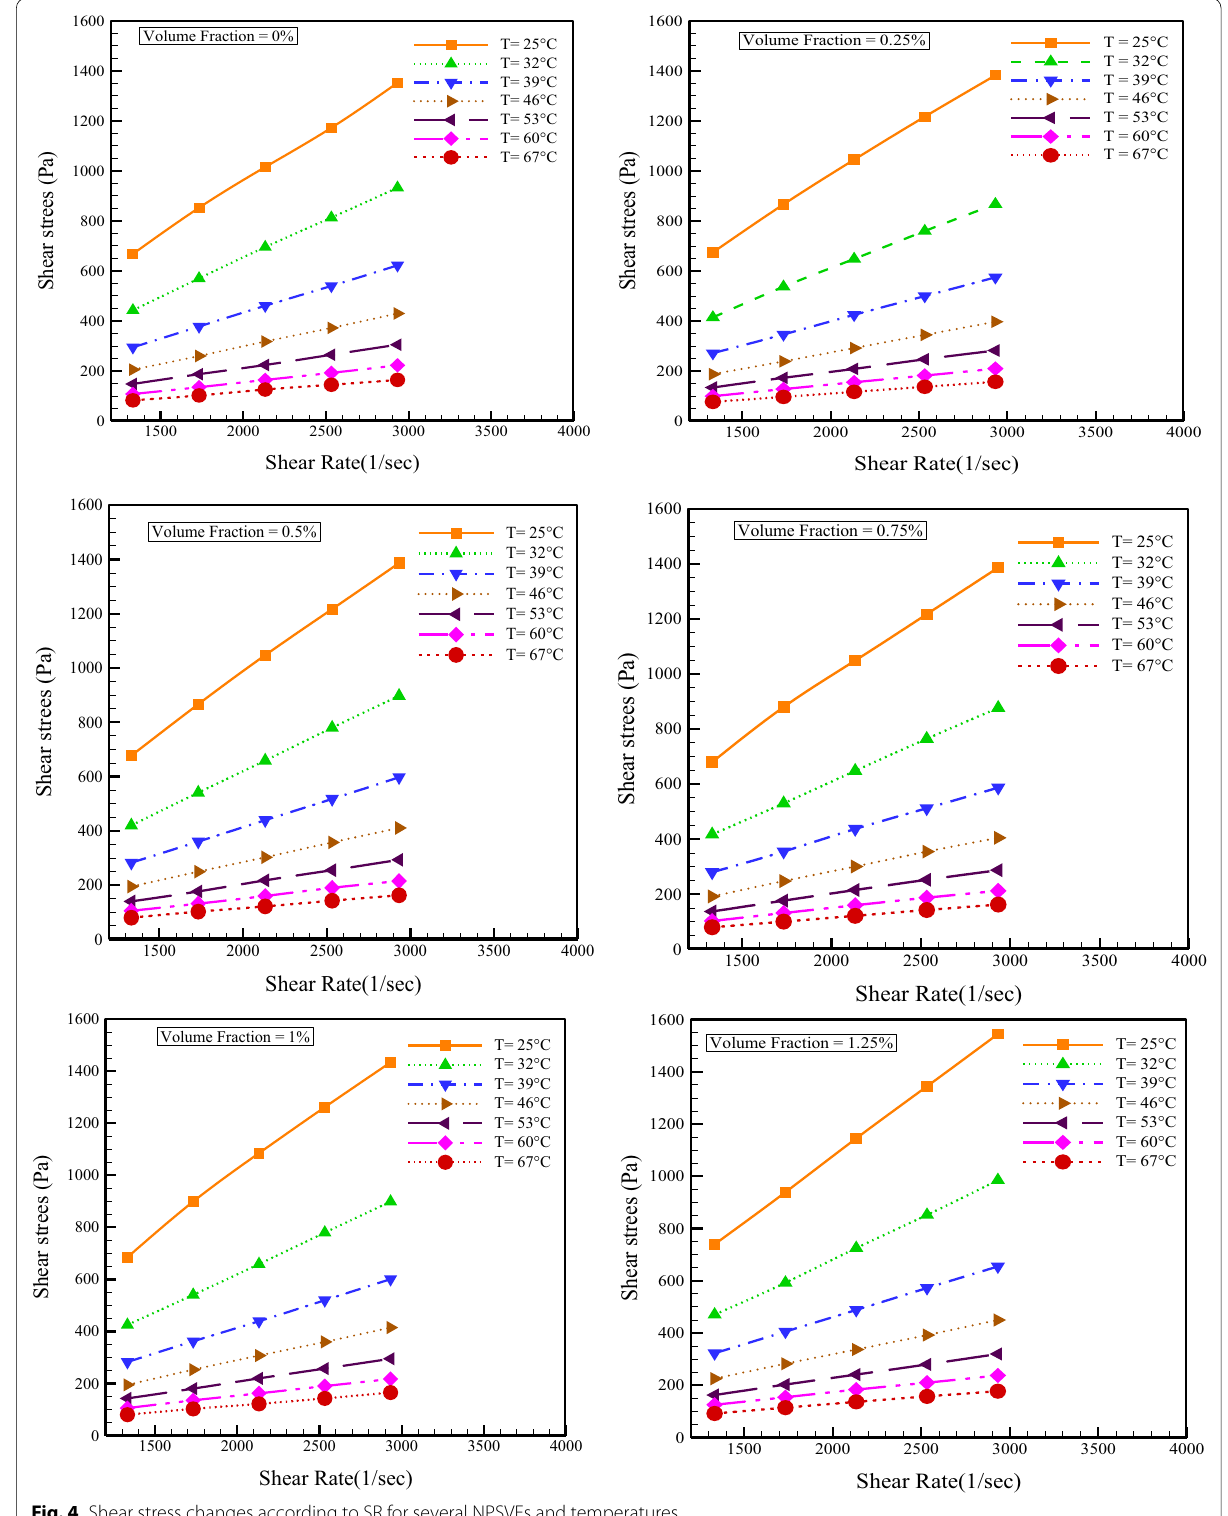
Fig. 4 Shear stress changes according to SR for several NPSVFs and